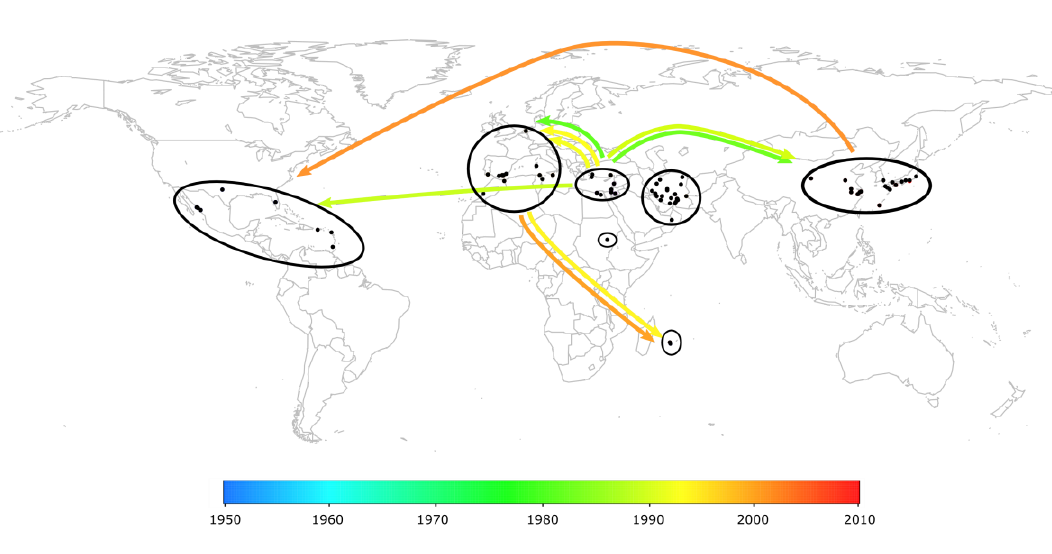
Figure 1 . Worldwide spread of Tomato yellow leaf curl virus (TYLCV) inferred using phylogeography analyses on the coat protein and full genome datasets [114]. According to the color scale at the bottom of the figure, arrow colors depict the mean ages (in years) of the migration